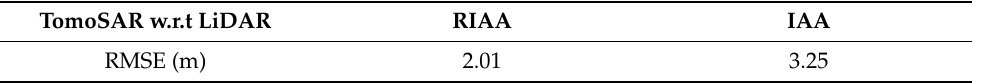
Table 7. RMSEs of the forest height estimated by RIAA and IAA with respect to the LiDAR